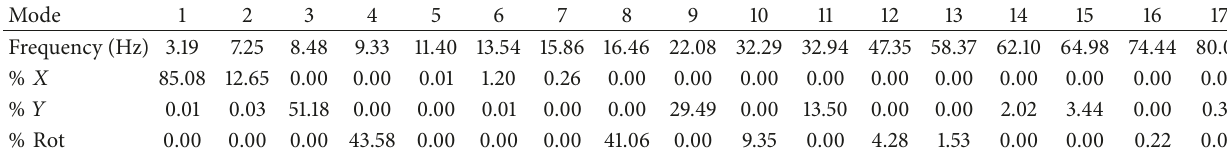
Table 12: Rigid connected (RC) configuration FE model natural frequencies and excited masses.